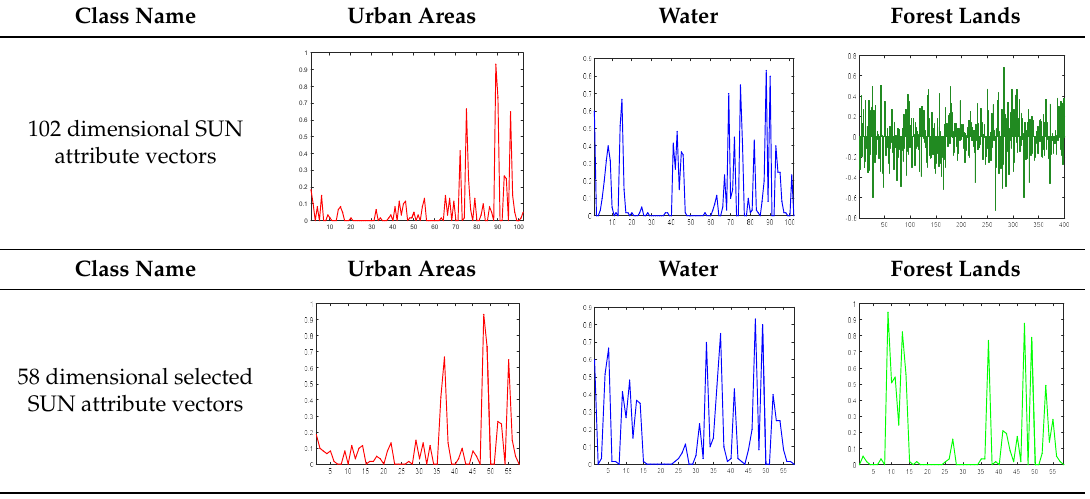
Table 2. The examples of the land cover class and corresponding SUN/selected SUN attribute vectors.